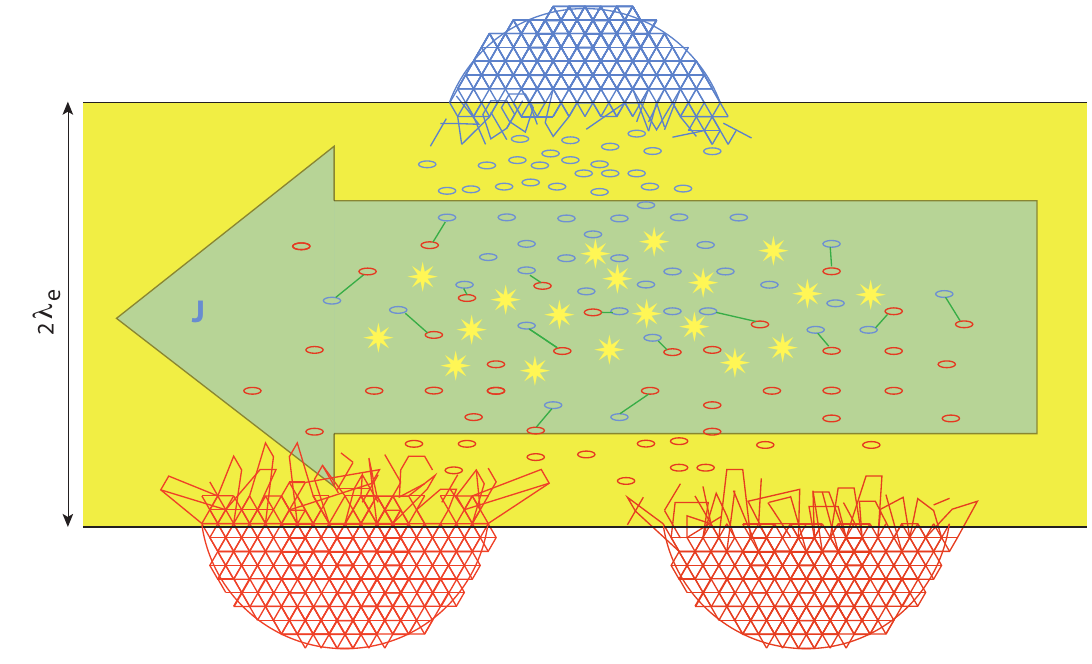
Fig. 1. Three meso-scale flux tubes encountering the electron inertial region at the centre of a (symmetric) current layer which separates two plasmas with anti-parallel fields. The (blue) field above the current J points into the plane, the (red) field below the current points out of the plane. Above and below the electron inertial layer the field is frozen to the electrons (not shown) forming a lattice structure. When entering the electron inertial region, the lattices break off and dissolve as the fields become released from the frozen-in state. Under the action of the repulsive gauge fields they seek to achieve larger distances whereby entering the central region. Meeting field lines of different polarity from the other side, they feel attractive gauge forces (indicated by green lines), approach each other and annihilate (yellow stars). The distribution of merging centres is statistical. Merged field lines relax and join up to produce macro-scale reconnection effects: jets